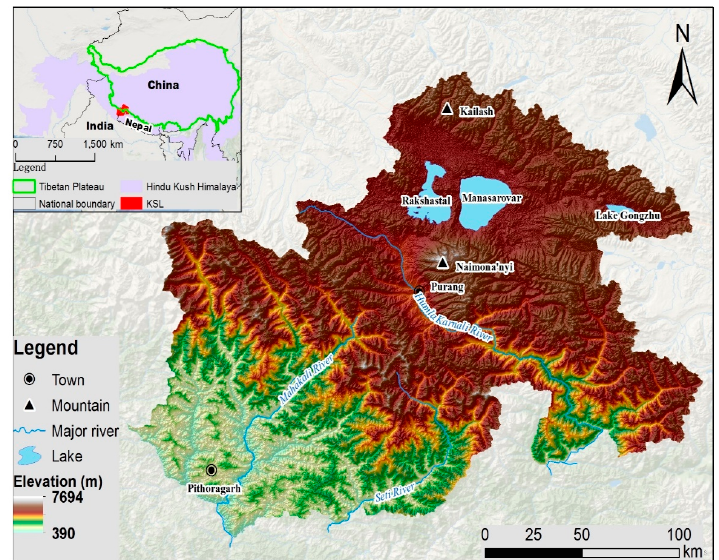
Figure 1. Map showing the location and topographic features of Kailash Sacred Landscape (KSL). The Hindu Kush Himalaya (HKH) boundary was obtained from https://rds.icimod.org/home/datadetail?metadataid=3924 (accessed on 8 February 2021) and the Tibetan Plateau boundary from Zhang et al. 2014 [55].